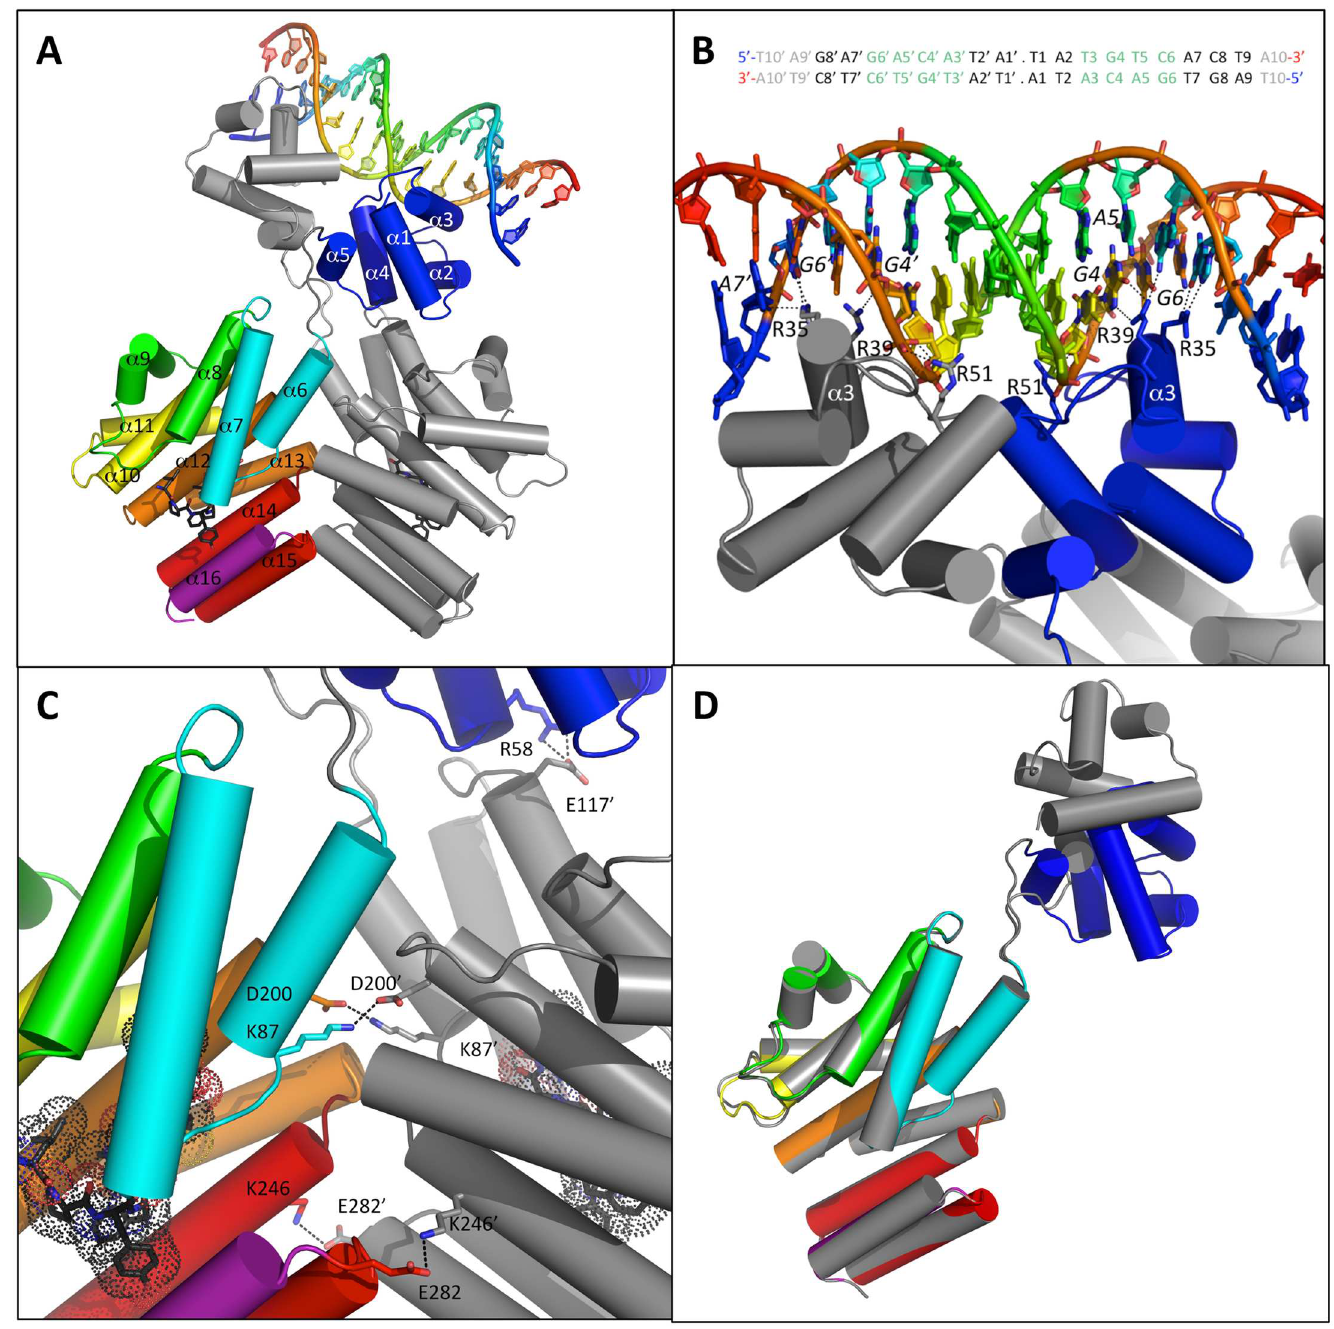
Fig 1. Crystal structure of the ComR/XIP/DNA ternary complex. A—Overall structure of the complex. The ComR dimer is shown as cartoon with chain A in gray and chain B colored by spectrum from TPR-1 in cyan to TPR-5 in red with the additional CAP helix α 16 in purpleand the HTH-domain in blue. The α -helicesare labelled.The 20-bp DNA fragment from the comX promoter is shown as cartoon colored by spectrum, from 5’ in blue to 3’ in red. The bound peptides are shown as black sticks. B–Close view of the HTH-DNA interaction. Same representation as panel A. The protein residues R35, R39 and R51 are highlightedin sticks coloredby atom type and labeled.The DNA bases of the conservedGACA motif are colored by atom type. The nucleotides directly interactingwith the protein are labeled.The sequenceof the crystallized20-bp DNA fragment is shownat the top of the panel with the conservedGACA motif highlighted in green. The flexible extremitiesnot visible in the electron density map are indicatedin gray. The base pairs are numbered from 1 to 10 in each half-site of this pseudopalindromicsequence. C—Close view of the TPR dimerization interface . Chain A in gray and chain B colored by spectrum. ResiduesK87, D200, K246 and E282 involvedin stabilizingsalt bridges are highlightedas well as residue R58 from chain B and E117 from chain A. D—Superimposition of the two TPR domains. ChainA in gray and chain B coloredby spectrum.